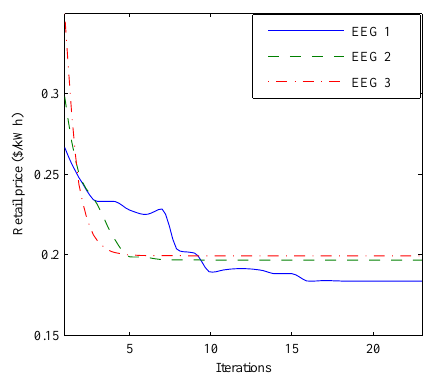
Figure 14. The retail prices under different EEGs.